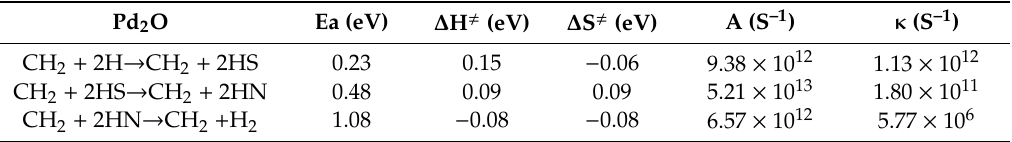
Table 5. The activation energy (E a ), difference enthalpy between the transition state and the initial state ( Δ H ≠ ), difference entropies between the transition state and the initial state ( Δ S ≠ ), pre-exponential factor (A), rate constant ( κ ) for methane activation on Pd 2 O.